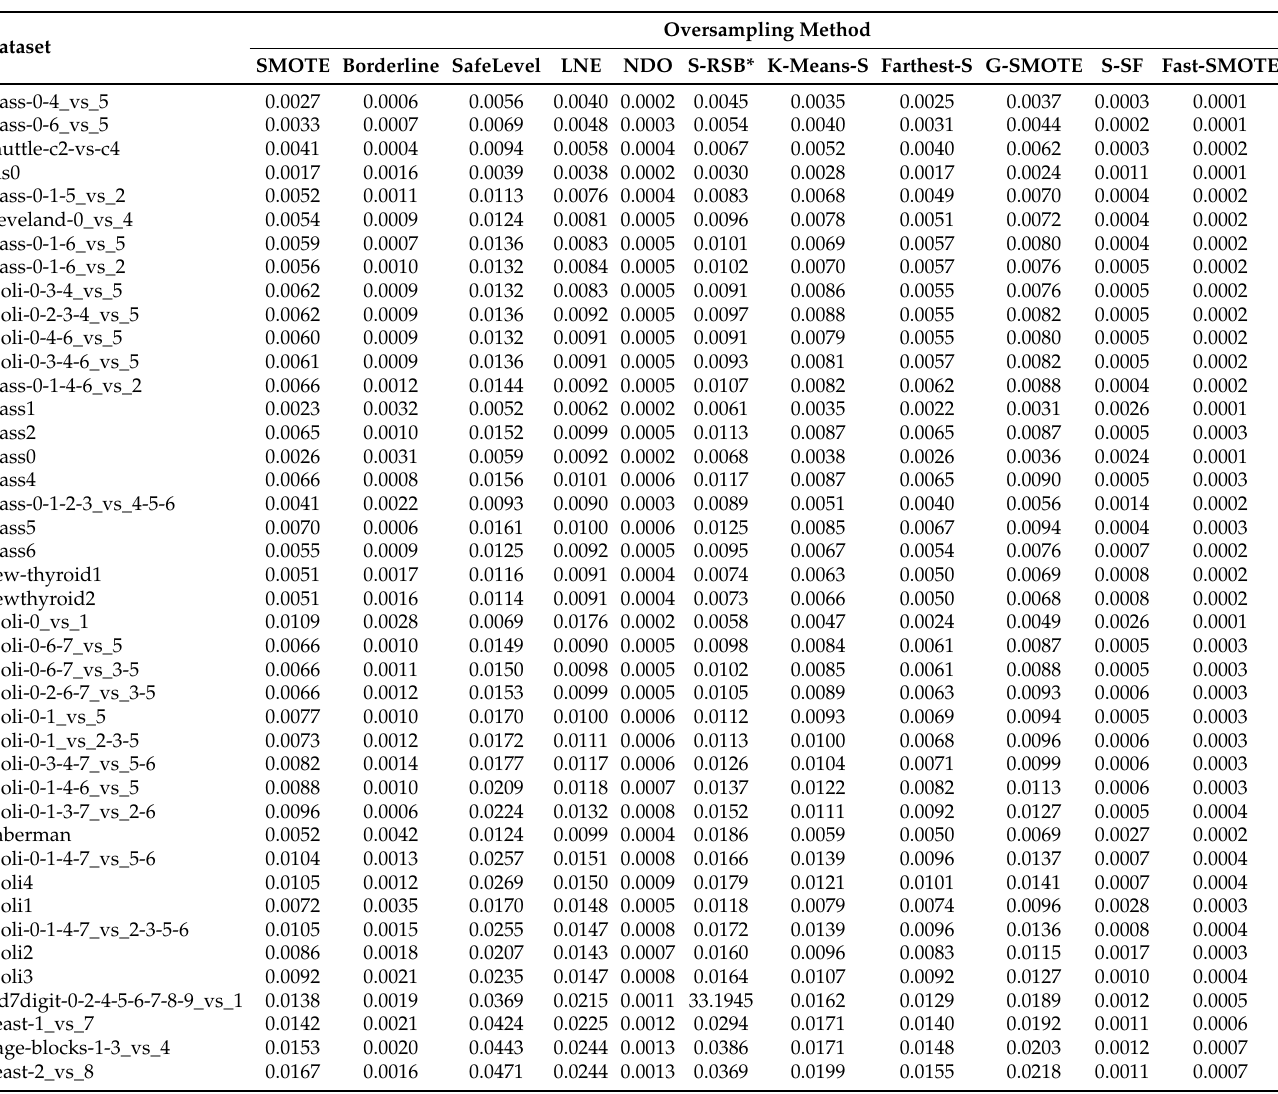
Table 4. Runtime in seconds spent by the oversampling methods revised in Section 2 for oversampling all datasets from Table